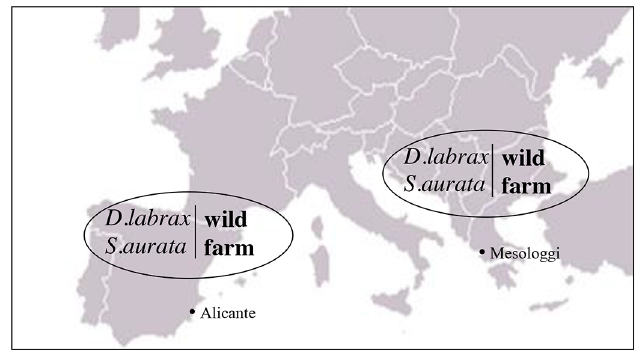
Fig 1. Geographic location of the sea bream and sea bass samples. All samples were taken from areas close to the two cities (Alicante in Spain and Mesologgi in Greece). For the exact sampling locations see Arechavala-Lopez et al.